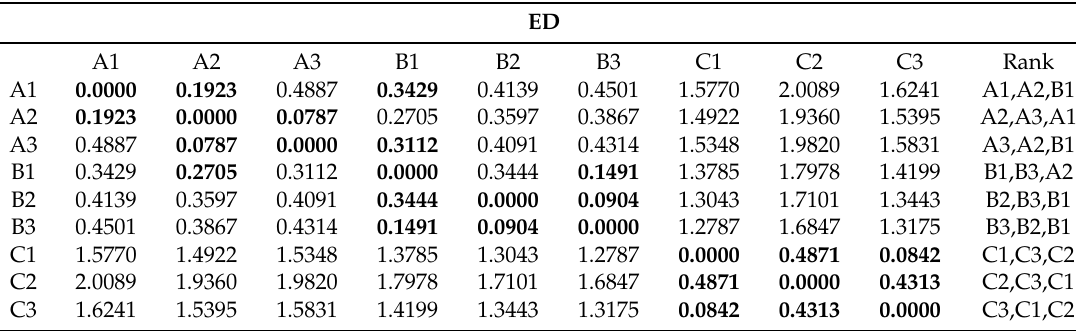
Table 8. The performance of ED for the ROSIS